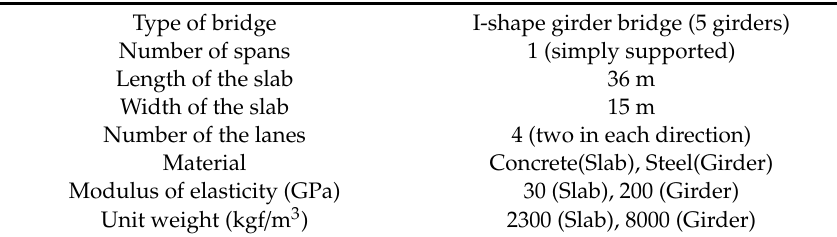
Table 4. Information for the bridge model.